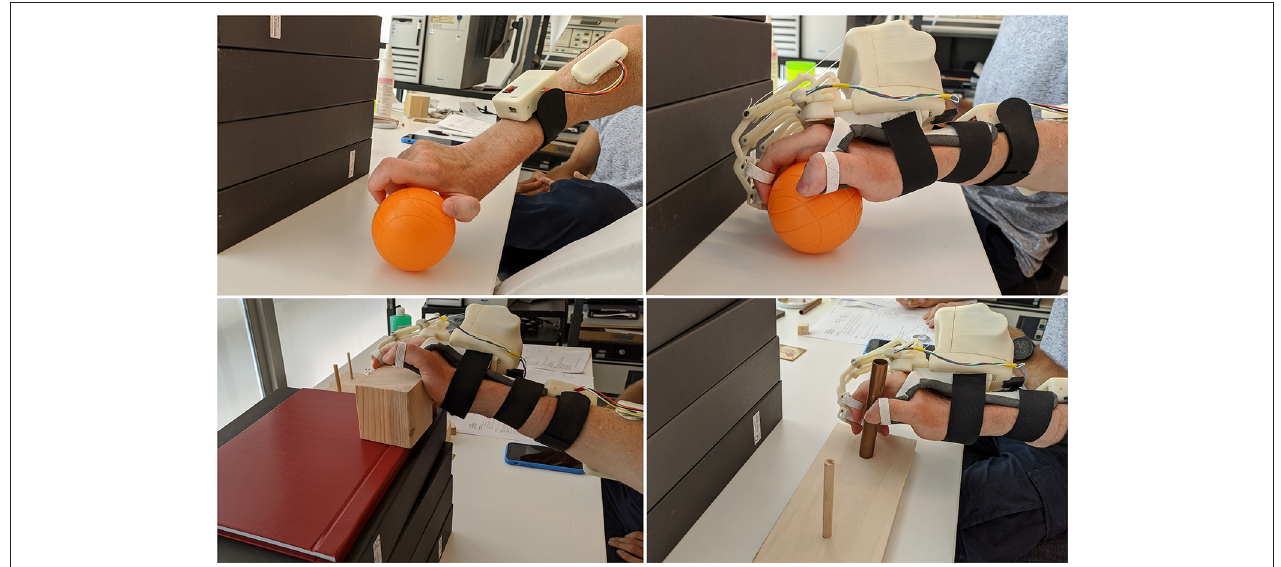
FIGURE 7 | The figure shows some pictures taken during the test: (i) on the top-left, the cricket ball grasping (G5) performed without the HES, (ii) on the top-right, the same task performed with the HES, (iii) on the bottom-left, the wooden block grasping (G1) is shown, while (iv) on the bottom-right, the alloy tube gripping (GR2) is